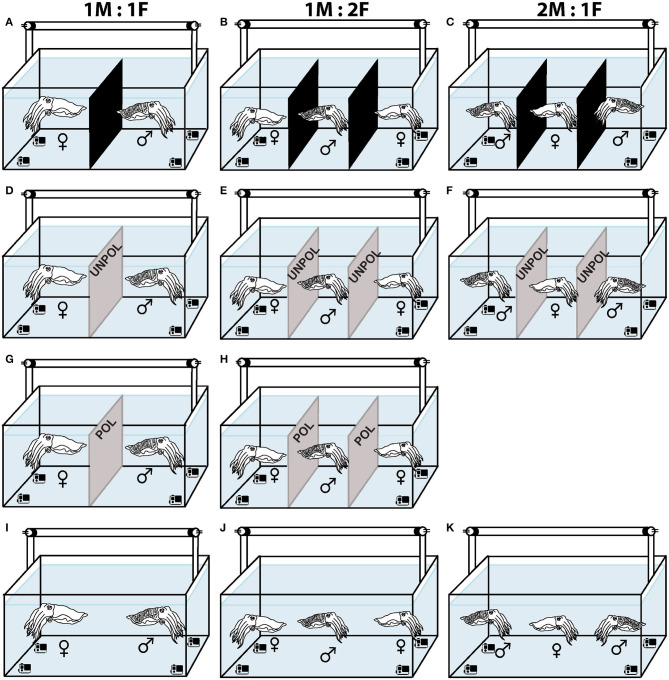
Schematic representation of the experimental design for mate choice. ♀ = Females. ♂ = Males. (A) One pair and three cuttlefish (B,C) with black dividers to limit visual contact before the start of the experiments. (D) Two cuttlefish with an unpolarized (UNPOL) barrier between them. (E,F) Three cuttlefish with unpolarized barrier in the tank. (G) A male and a female with a polarized (POL) barrier between them. (H) Three cuttlefish with polarized barrier in the tank. (I–K) Two or three cuttlefish in control (DIRECT) condition. (A,D,G,I) Sex ratio = 1M:1F. (B,E,H,J) = 1M:2F. (C,F,K) = 2M:1F.